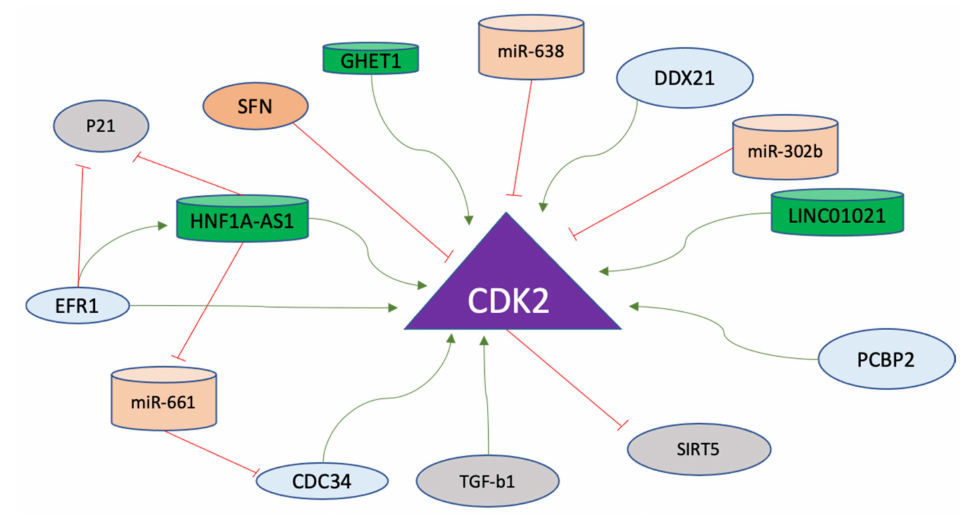
Figure 6. CDK2 regulation in gastric cancer progression. CDK2 is the major driver of the S phase in the cell cycle and promotes various pathways. Positive regulators (green arrows) including long non- coding RNAs (green) and negative regulators of CDK2 (red lines), including micro-RNAs (orange), are shown. The details of the mode of action of these molecules on CDK2 are explained in the